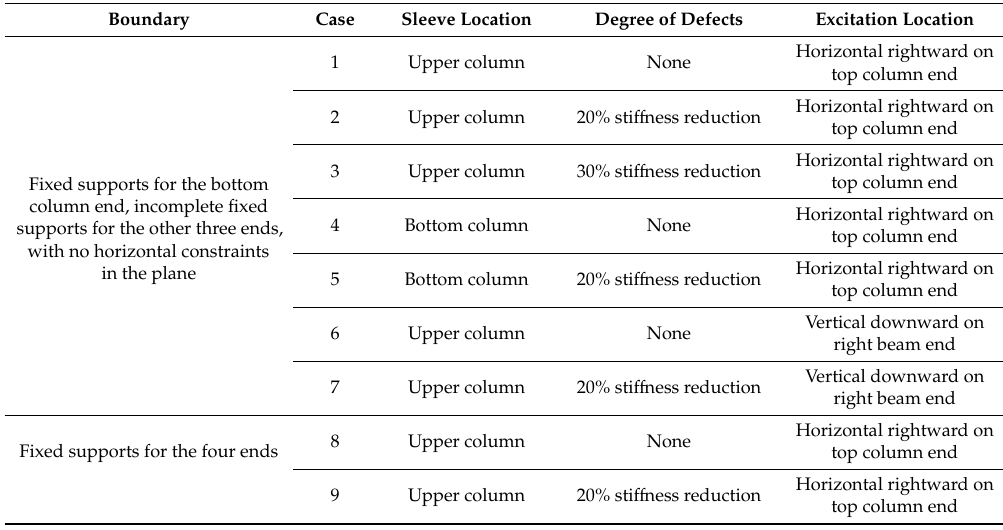
Table 1. Working cases in the numerical simulations.